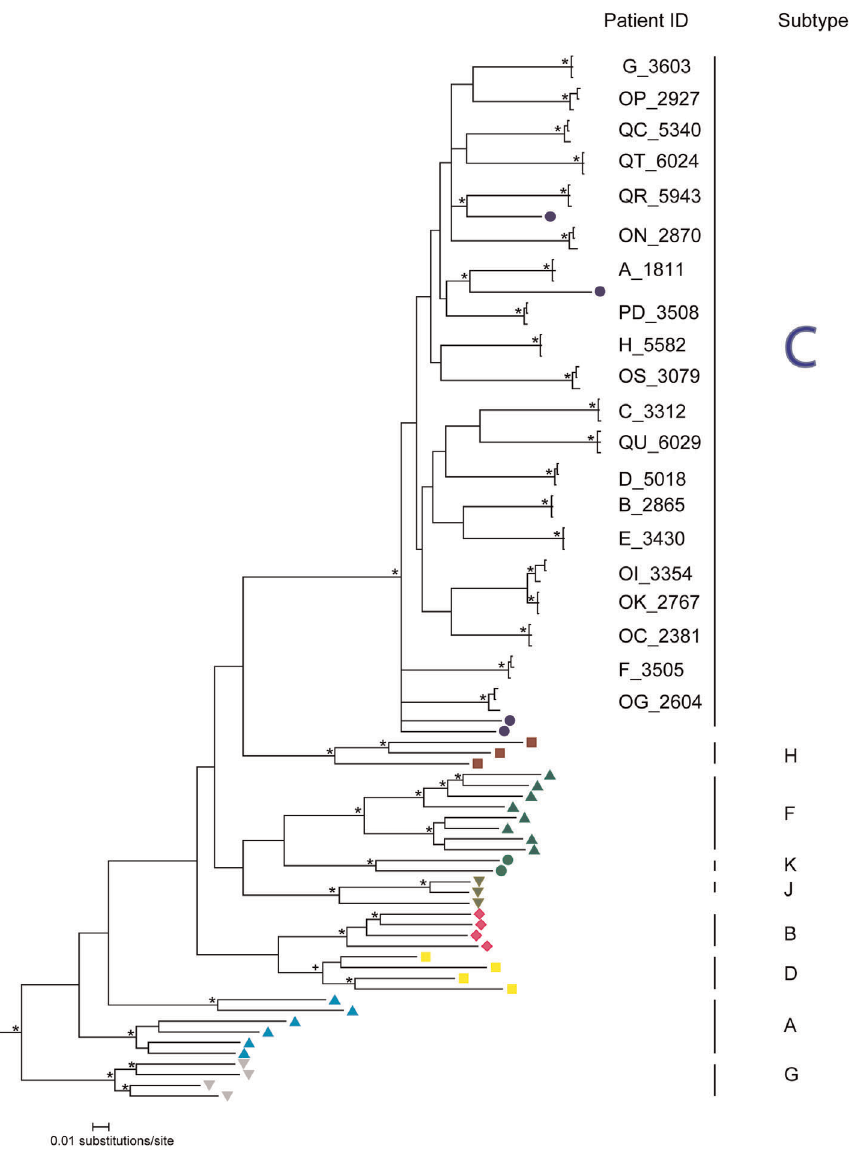
Figure 1. HIV-1 subtyping by analysis of phylogenetic relationships of HIV-1 non-structural genes. The analyzed region of HIV-1 genome corresponded to nucleotide positions 5,041 to 6,310 in HXB2. Three sequences were randomly selected for each study subject (see Methods). A phylogenetic tree was inferred by Mr. Bayes using GTR model. The convergence was reached after 10 M MCMC run. The consensus tree was visualized in Figtree v.1.3.1 [54]. Clade credibility values of . 0.95 shown by asterisk, Subtype D cluster showed the support of 0.93 indicated by + symbol. HIV-1 subtype C reference sequences are shown as blue circles. All non-subtype C group M reference sequences are shown at the bottom of the phylogenetic tree. SIV sequence (CPZ.CM98.CAM3.AF115393) was used as an outgroup.